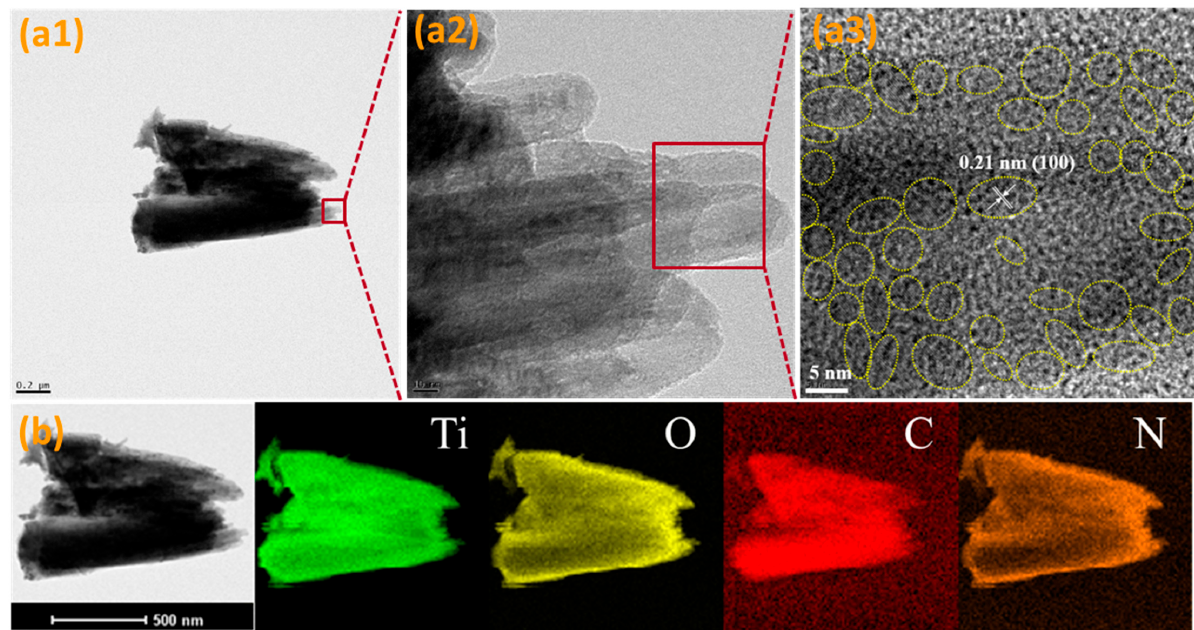
Figure 2. ( a1 – a3 ) FETEM of TiO 2 @NCD4h. ( b ) HAADF-STEM of TiO 2 @NCD4h and elemental mapping for Ti, O, C, and N.